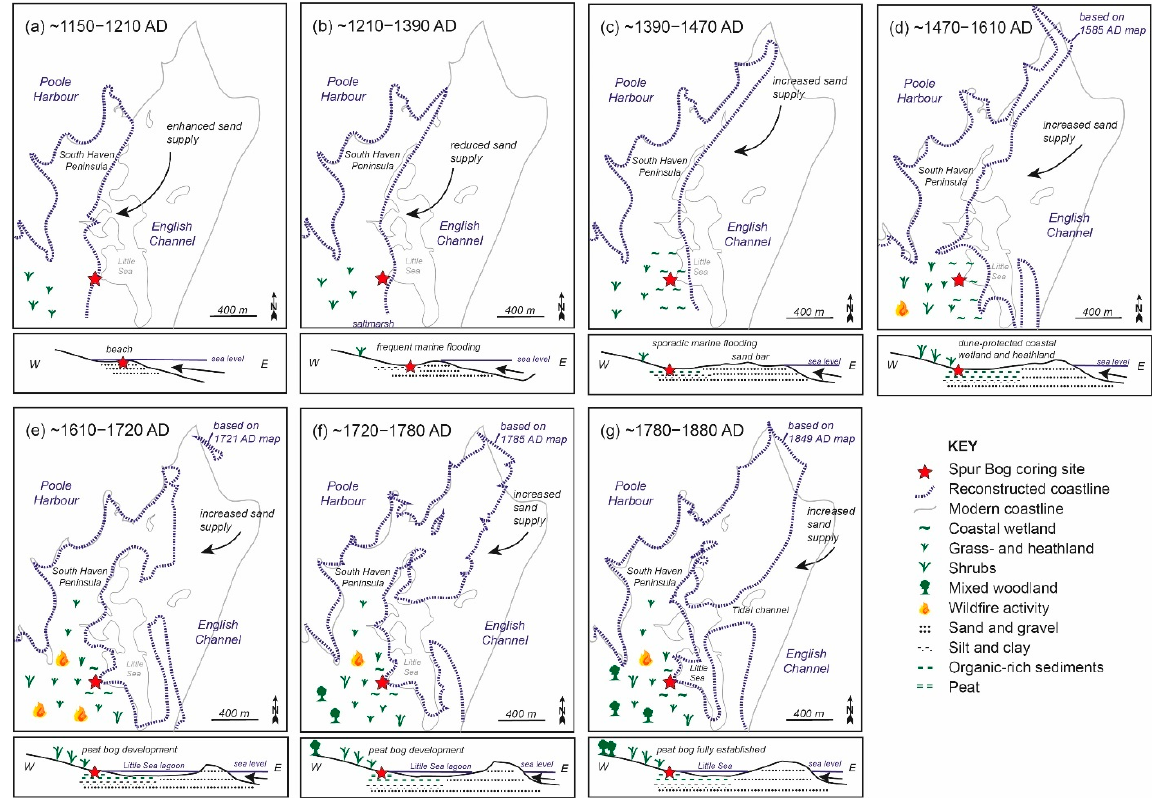
Figure 10. Schematic maps and cross-section models (not to scale) depicting geomorphological changes at the South Haven Peninsula and landscape/ecological changes at the site of Spur Bog (red star) during the last ~900 years. ( a ) The period ~1150–1210 AD: intertidal zone; ( b ) ~1210–1390 AD: coastal floodplain with saline tolerant grassland; ( c ) ~1390–1470 AD: sporadically flooded coastal wetland; ( d ) ~1470–1610 AD: dune-protected coastal wetland and heathland; coastline defined by using the map from [17]; ( e ) ~1610–1720 AD: spur peat bog development in an expanding grassland environment; increase in wildfire activity; coastline defined by using the map from [6,23]; ( f ) ~1720–1780 AD: spur peat bog development; transition from grassland to mixed woodland; development of Little Sea; decrease in wildfire activity; coastline defined by using the map from [6,25]; ( g ) ~1780–1880 AD: spur peat bog fully established; further development of Little Sea; further expansion of woodlands; coastline defined by using the map from [6,26].